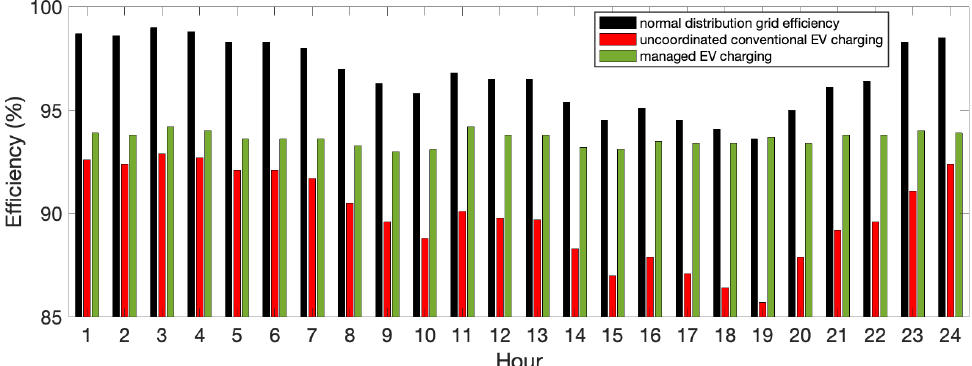
Figure 4. Comparison of distribution system efficiency of different